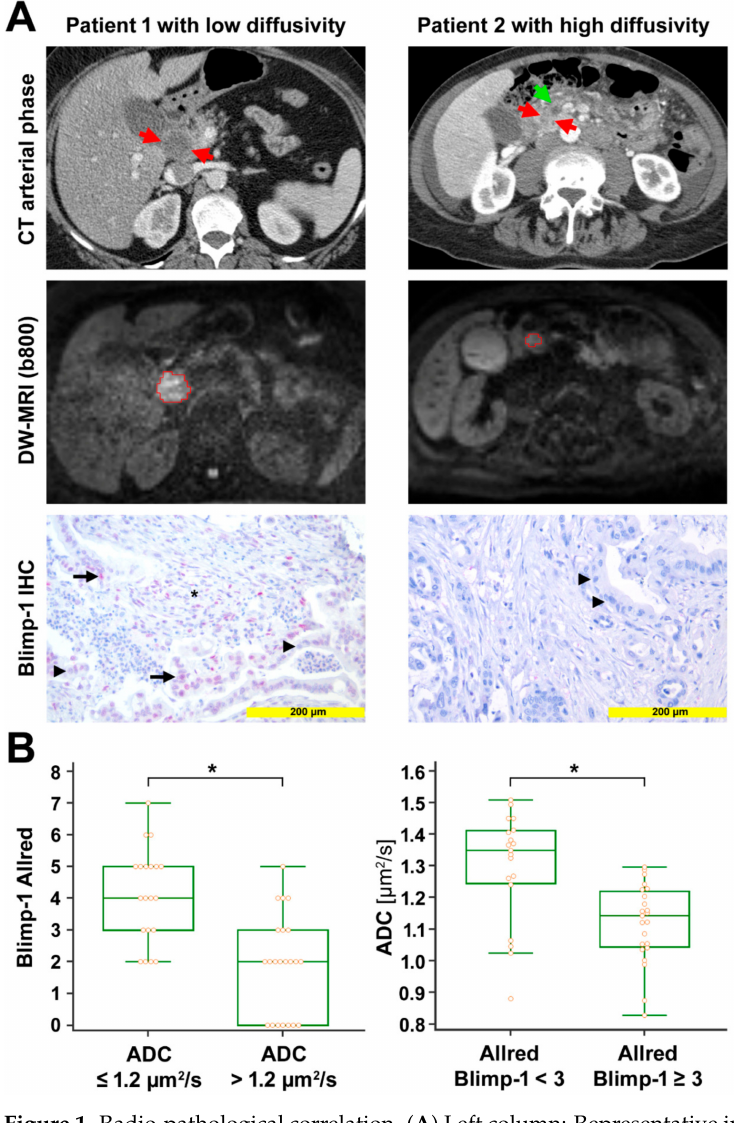
Figure 1. Radio-pathological correlation. ( A ) Left column: Representative images from a patient with low diffusivity. Late arterial phase computed tomography (CT) image shows the hypodense tumor in the head of the pancreas (red arrows). Diffusion-weighted image (DWI) with the volume of inter- est (VOI, red) from radiologist 1 encompassing the markedly hyperintense tumor (b = 800 s/mm 2 ). Mean apparent diffusion coefficient (ADC) value for both radiologists was 0.875 µ m 2 /s. Anti-Blimp-1 immunohistochemical staining shows pancreatic cancer tissue with partial Blimp-1 expression in moderate intensity (red nuclei; arrow); Blimp-1 Allred score was 5 in this example. Negative nuclei are marked with arrowheads. Blimp-1 infiltrated immune cells in the tumor stroma, marked by an asterisk. Right column: Representative images from a patient with high diffusivity. Late arterial phase CT image shows the hypodense tumor in the pancreatic head (red arrows). The pancreatic duct is dilated in the upstream parenchyma (green arrow). DWI with the VOI (red) from radiolo- gist 1 encompassing the mildly hyperintense tumor (b = 800 s/mm 2 ). Mean ADC value for both radiologists was 1.509 µ m 2 /s. Anti-Blimp-1 immunohistochemical staining shows pancreatic cancer tissue without nuclear Blimp-1 (blue nuclei; arrowheads). ( B ) The box-and-whisker plots show the distribution of Blimp-1 Allred scores relative to ADC values ( left ) and the distribution of ADC values relative to Blimp-1 Allred scores (right). * p <